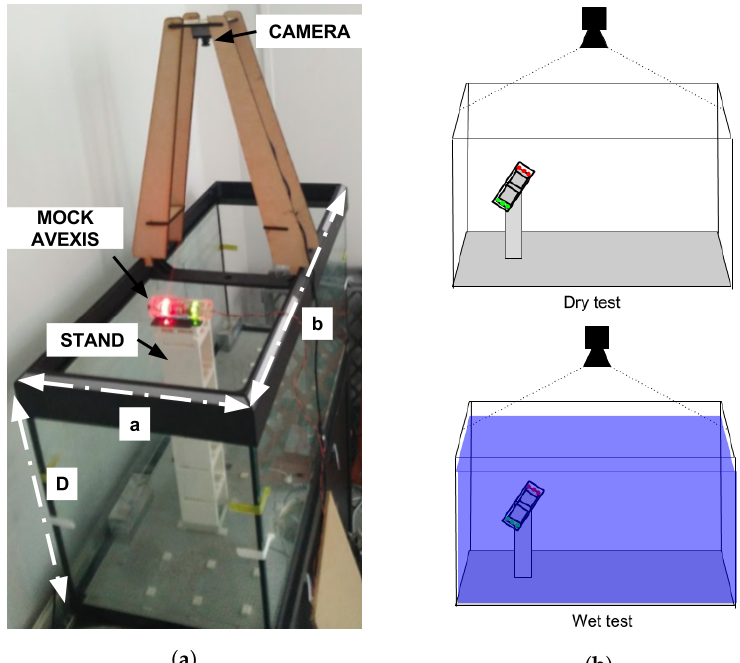
Figure 11. Experimental verification of mock AVEXIS TM with Z-axis variation. The real-world test setup can be seen in ( a ), whilst ( b ) outlines that the test was completed both in a submerged and in-air environment.